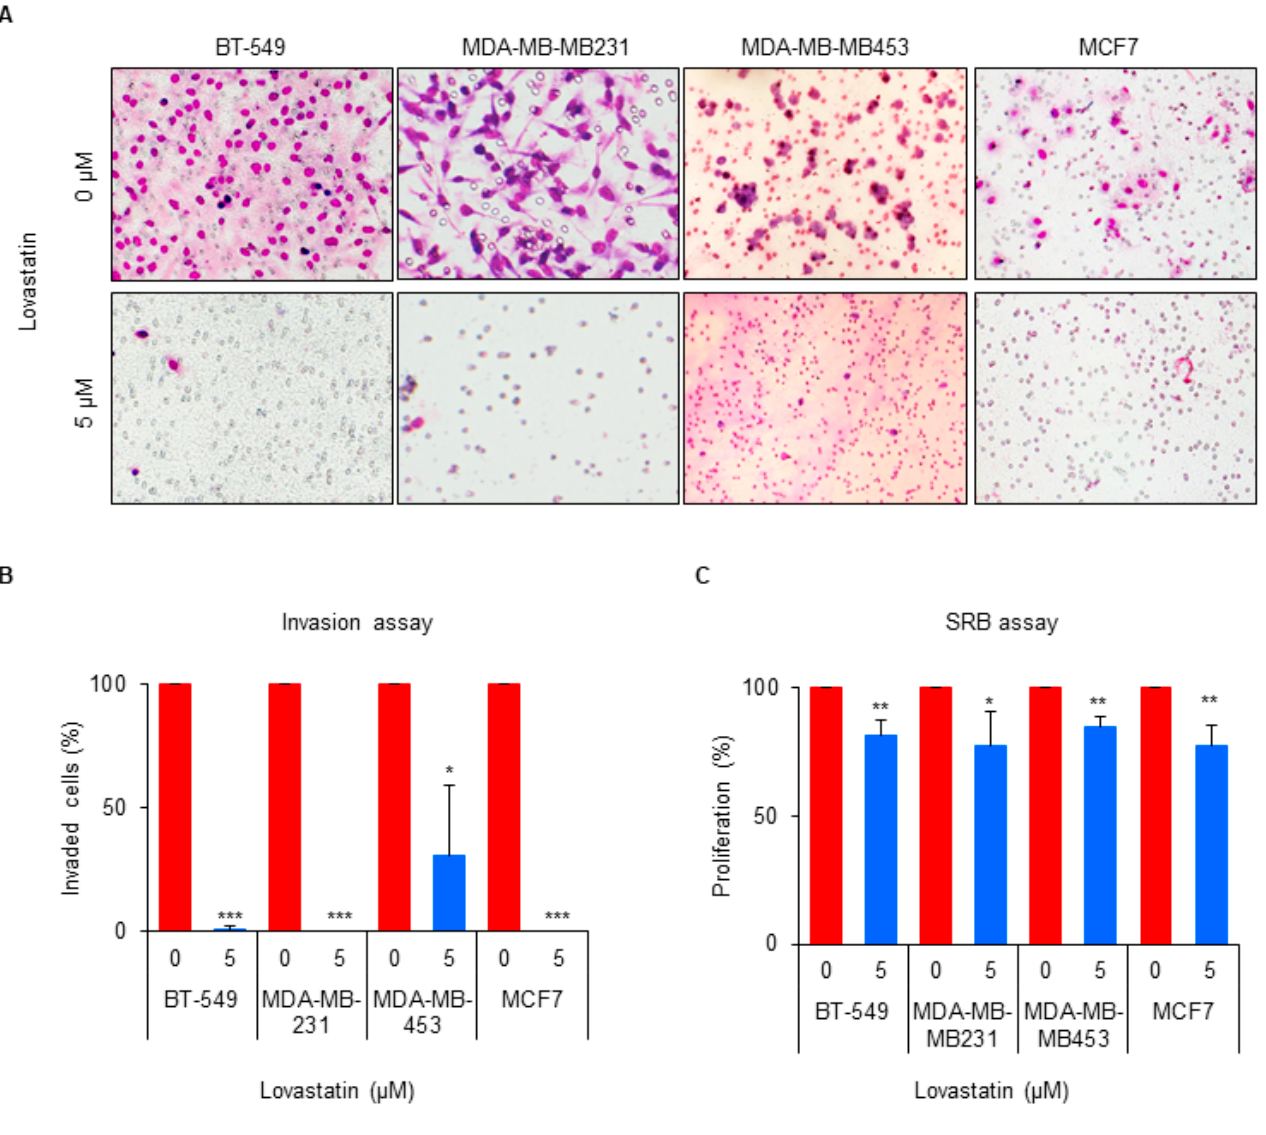
Figure 5. Cholesterol synthesis is important for the invasion of breast cancer cells. ( A ) BT-549, MDA-MB-231, MDA-MB-453, and MCF7 cells were treated with the 5 μ M of lovastatin for 48 h, and then seeded for Boyden chamber invasion assay. After 16 h, invaded cells were stained and counted. ( B ) The proportion of invaded cells was quantified as the mean ± standard deviation of three independent experiments. * p < 0.05, *** p < 0.001 relative to no treat cells. ( C ) The effect of lovastatin on breast cancer cell growth under the conditions shown in Figure A was determined by SRB assay. The relative proliferation of cells was quantified as the mean ± standard deviation of three independent experiments. * p < 0.05, ** p < 0.01 relative to non-treated cells.